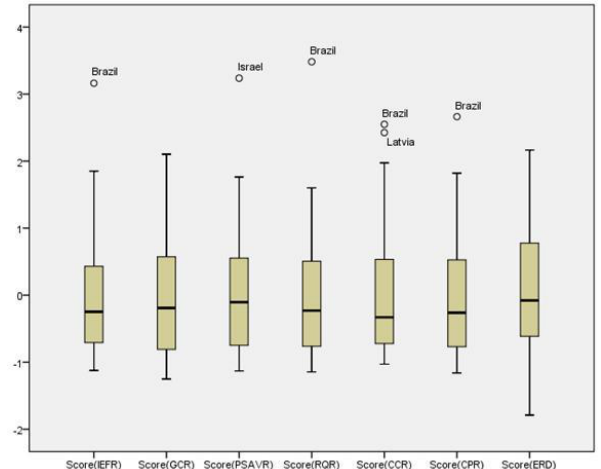
Figure 2. Bloxpot of the Macroeconomic Variables of the 30 Most Innovative Countries and Brazil for 2012.